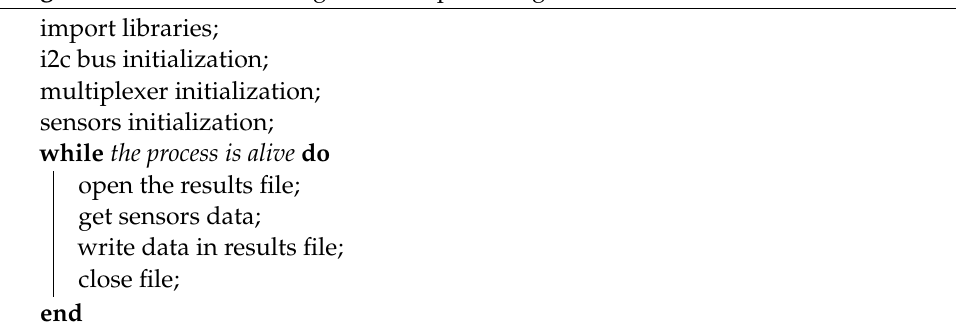
Algorithm 1: Sensor readings and sample storage.